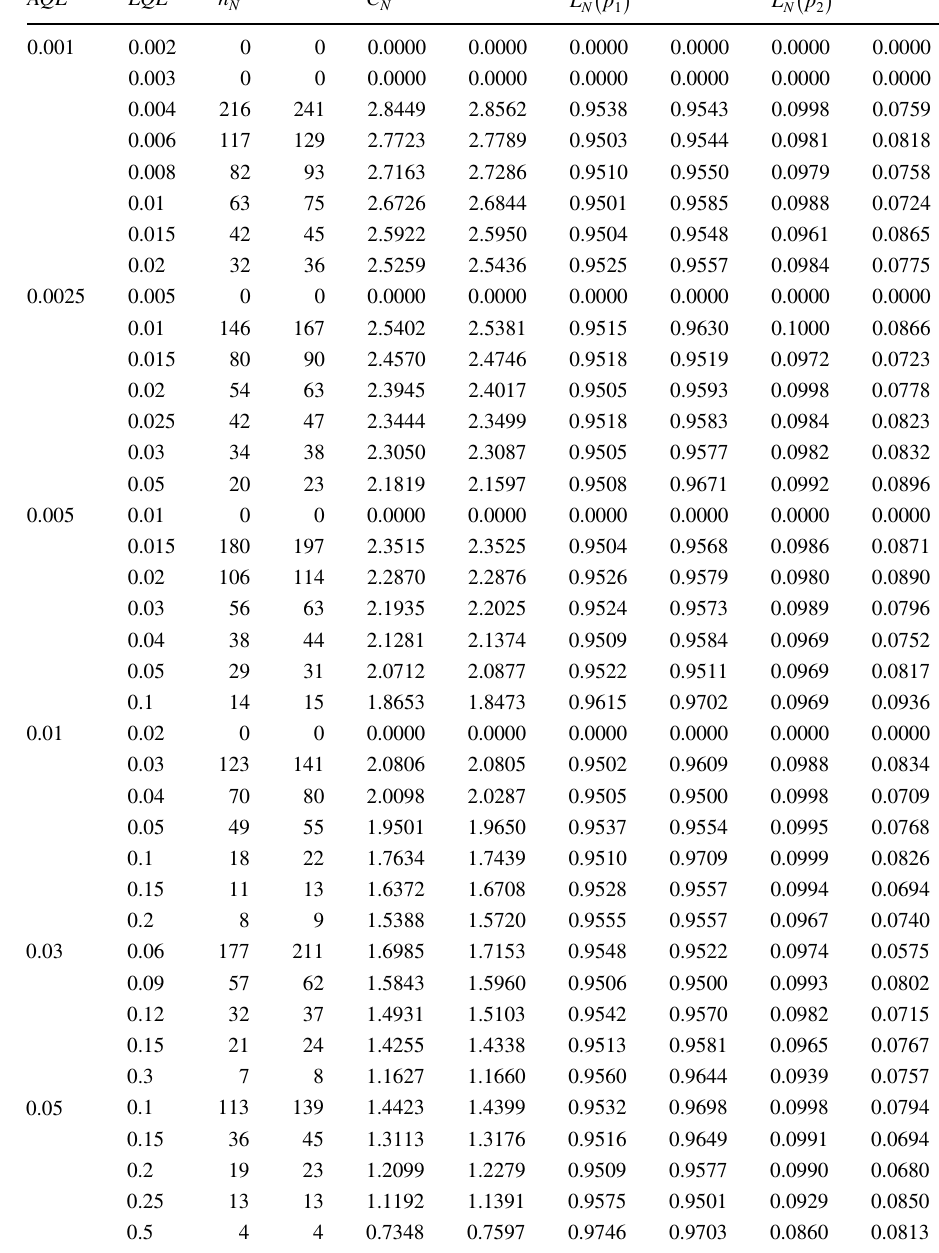
Table 8 Plan parameters for the proposed plan, when 𝜎 Y N is = 0.95 unknown and 𝜌 X N Y N